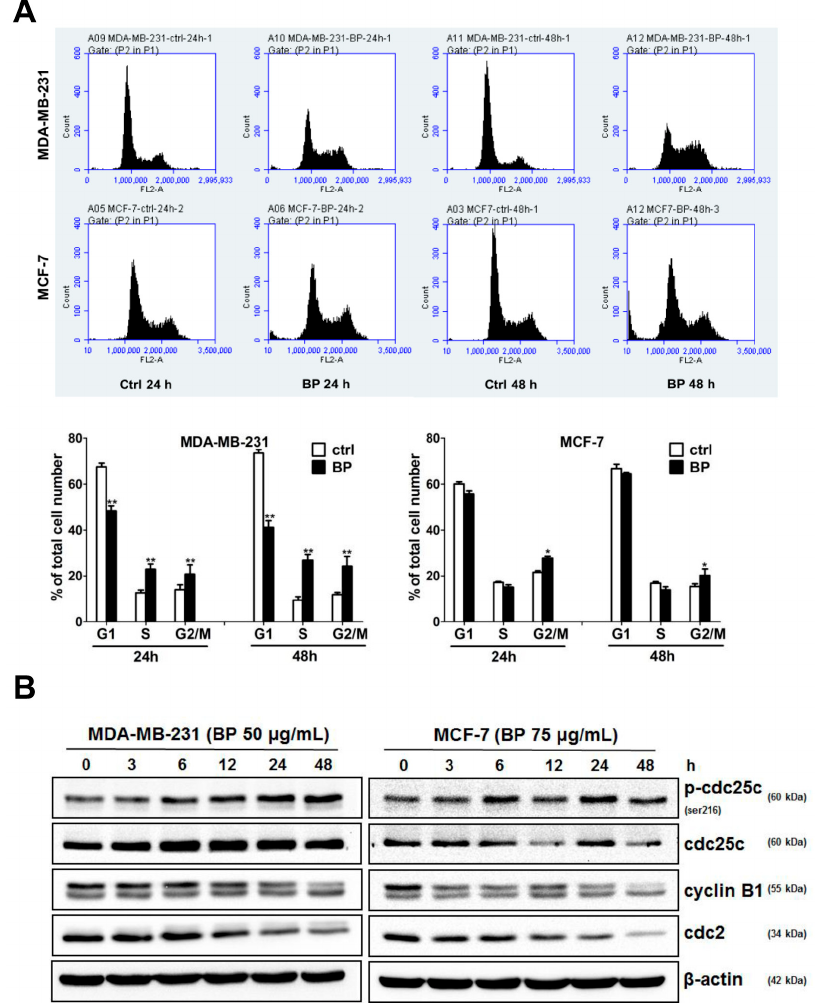
Figure 2. BP induced accumulation of G2/M cell population and changed the expression profiles of G2/M regulatory proteins in human breast cancer cells. ( A ) Human breast cancer cells were incubated with BP for 24 and 48 h and then analyzed by flow cytometry. Data are presented as mean ± S.D. obtained from three independent experiments, * p < 0.05 vs. vehicle; ** p < 0.01 vs. vehicle; ( B ) Human breast cells were treated with BP for 3 to 24 h. Western blot analysis of p-cdc25c (ser216), cdc25c, cyclin B1, and cdc2 was performed.